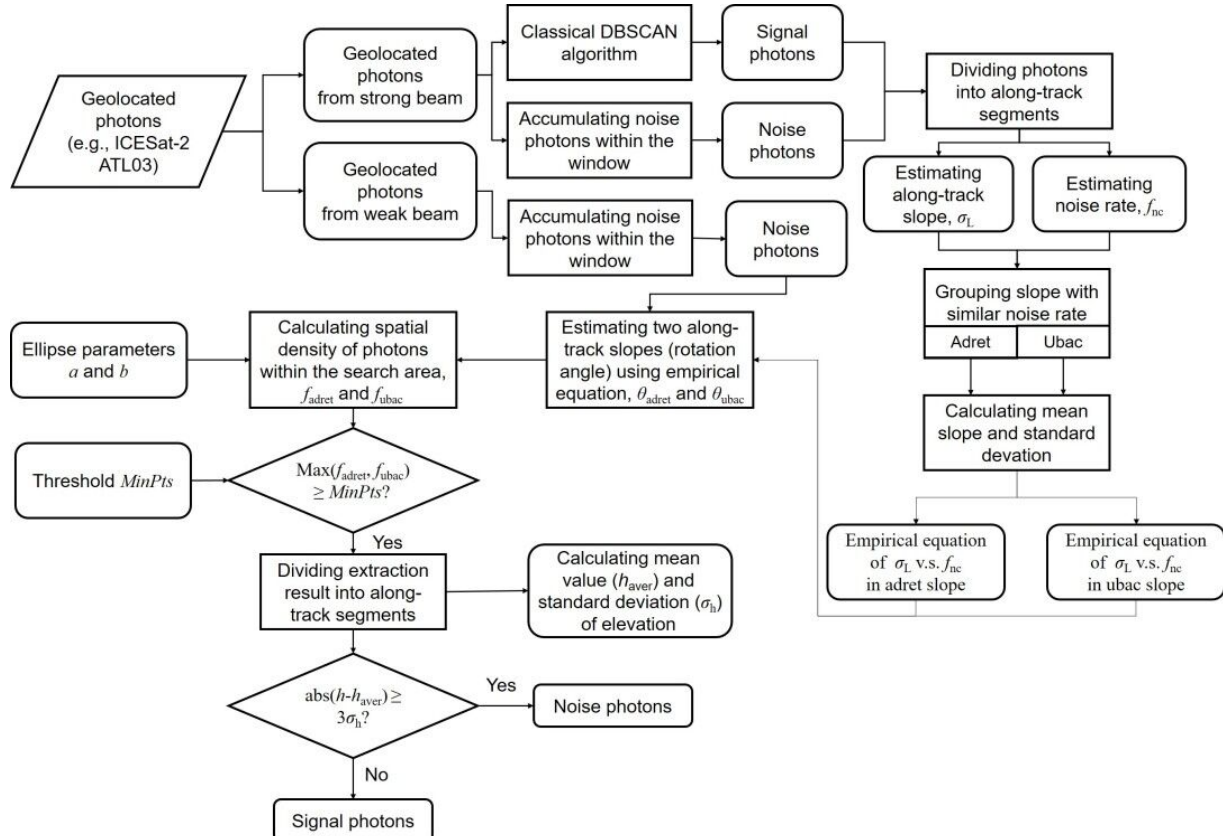
Figure 8. Flow chart of the modified DBSCAN algorithm in this study.